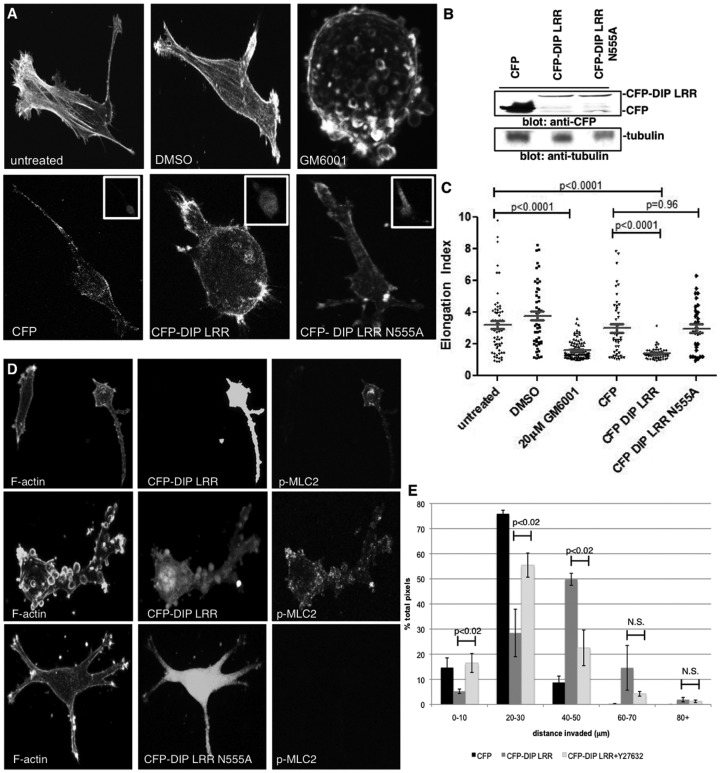
DIP LRR induces amoeboid motility in invading mesenchymal breast cancer cells.(A, B) MDA-MB-231 cells were treated with DMSO vehicle, 20 µm MMP-inhibitor GM6001 or were transfected with the indicated CFP-fusion proteins and were embedded in type-I collagen gels and stained as above. Insets validate the CFP-transfection. (C) Elongation indices were calculated as in 3C. (D) MDA-MB-231 cells transfected with either CFP-DIP LRR or CFP-DIP LRR N555A for 48 hrs were embedded in collagen gels overnight, stained with phalloidin and anti-pMLC2 antibodies. (E) MDA-MB-231 cells transfected for 48 hrs with CFP, CFP-DIP LRR or CFP-DIP LRR treated with 90 µM Y27632 reverse-invaded for 24 hrs through transwells coated with collagen I gels. Upon fixation, transwells were imaged by confocal microscopy. CFP pixels were calculated for 10 µm optical slices.